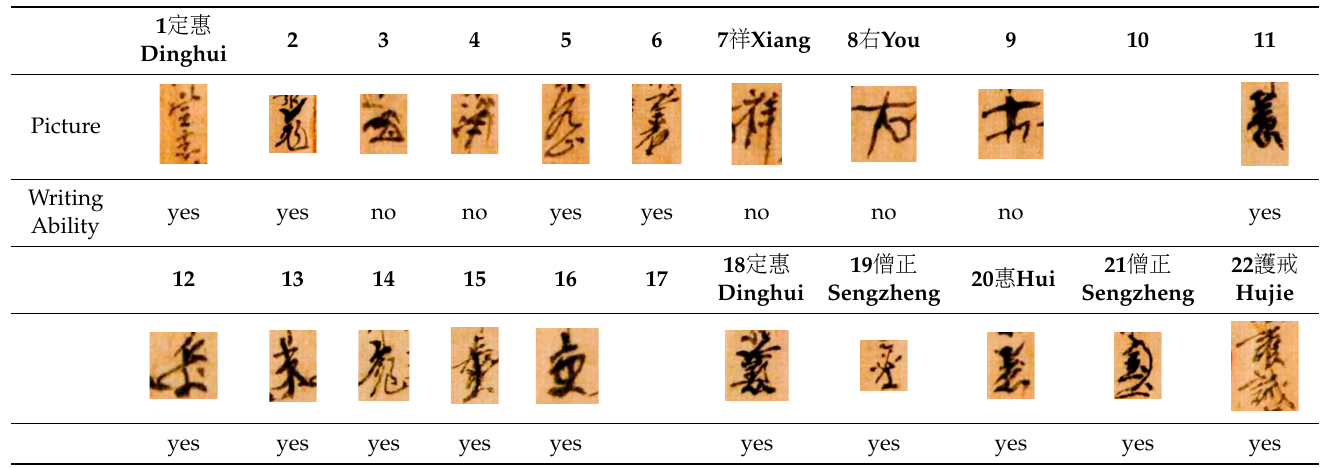
Table 6. Calligraphy of monks of Dayun Monastery in 986.